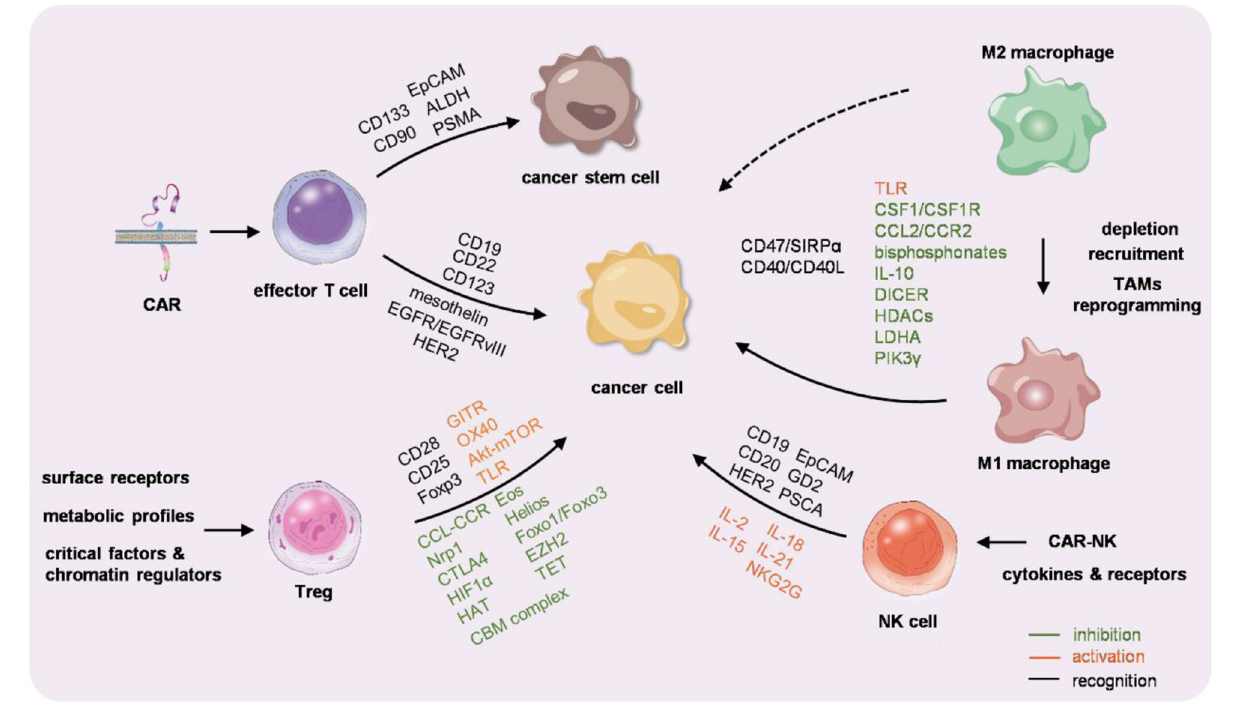
effective responses of CAR-NK cells were observed in ALL, prostate carcinoma, and osteosarcoma, while the effects in other cancers tested were not that satisfactory